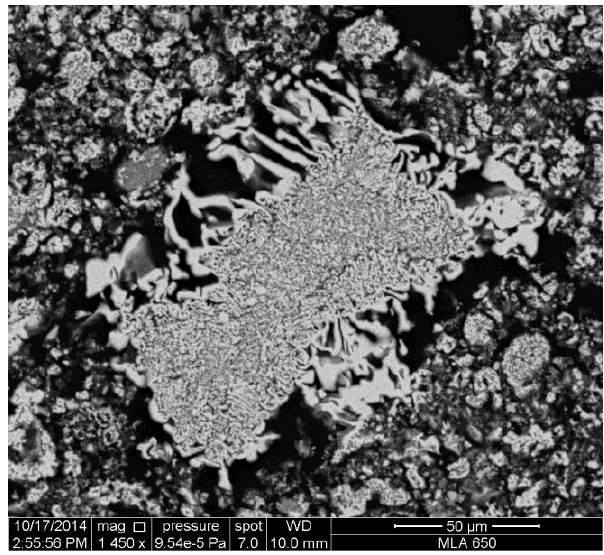
Figure 8. Generation of the metallic “whiskers” at the contacts of the pellets fines and